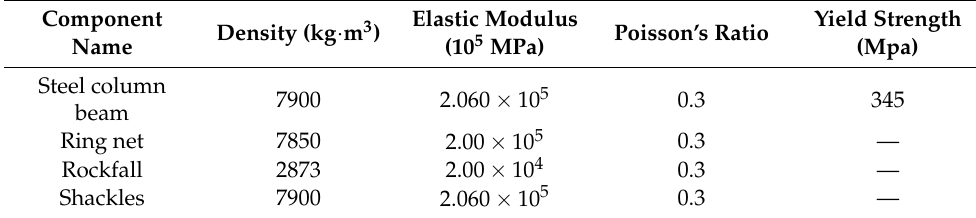
Table 7. Model parameters in the dynamic impact